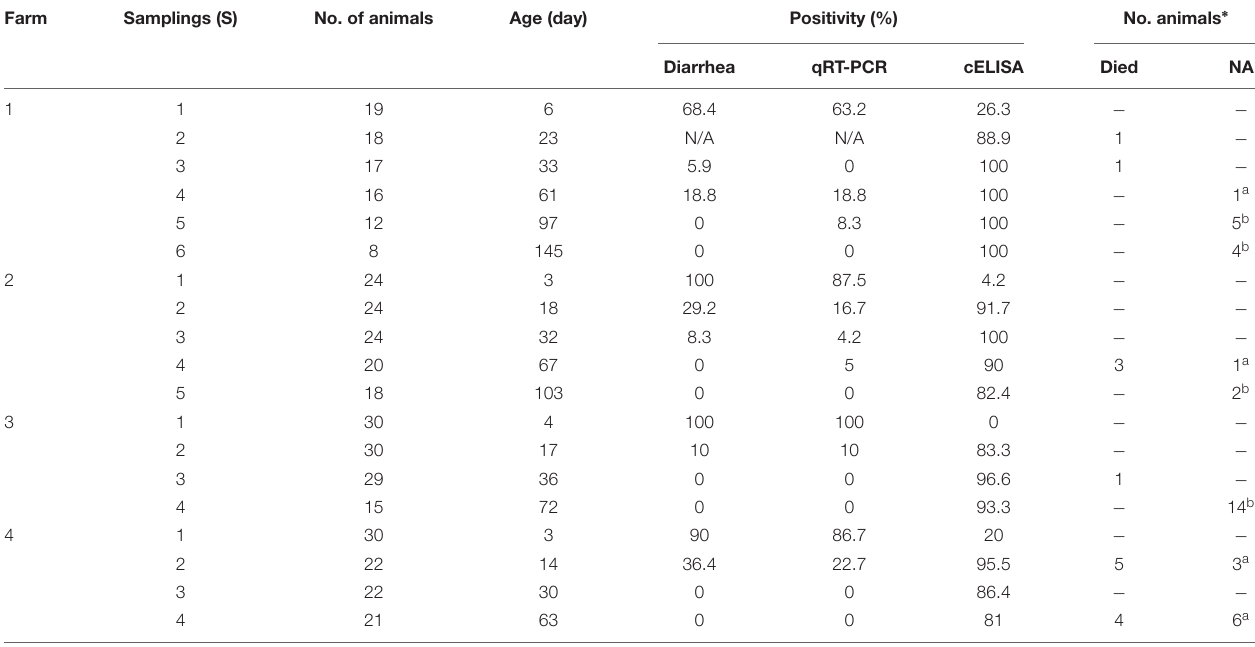
TABLE 5 | Diarrhea, PEDV detection, and cELISA results for animals from 3 to 145 days of age. Farm Samplings (S) No. of